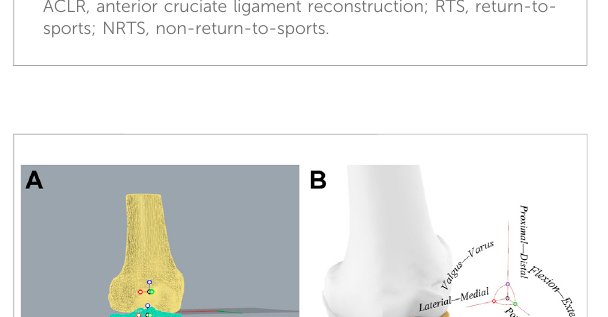
FIGURE 1 CONSORT (Consolidated Standards of Reporting Trials) fl ow diagram for kinematic evaluation. ACL, anterior cruciate ligament; ACLR, anterior cruciate ligament reconstruction; RTS, return-to- sports; NRTS, non-return-to-sports.